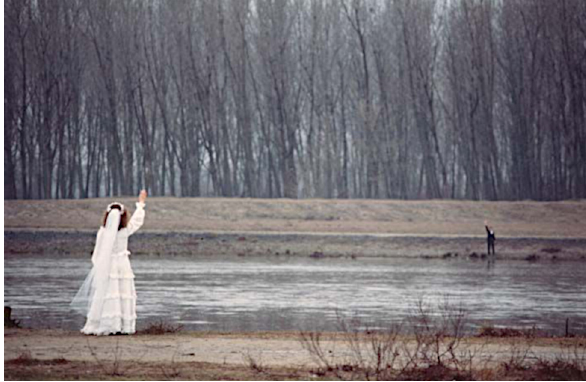
Figure 1. Frame of the movie “The suspended step of the stork” (Angelopoulos, 1991)